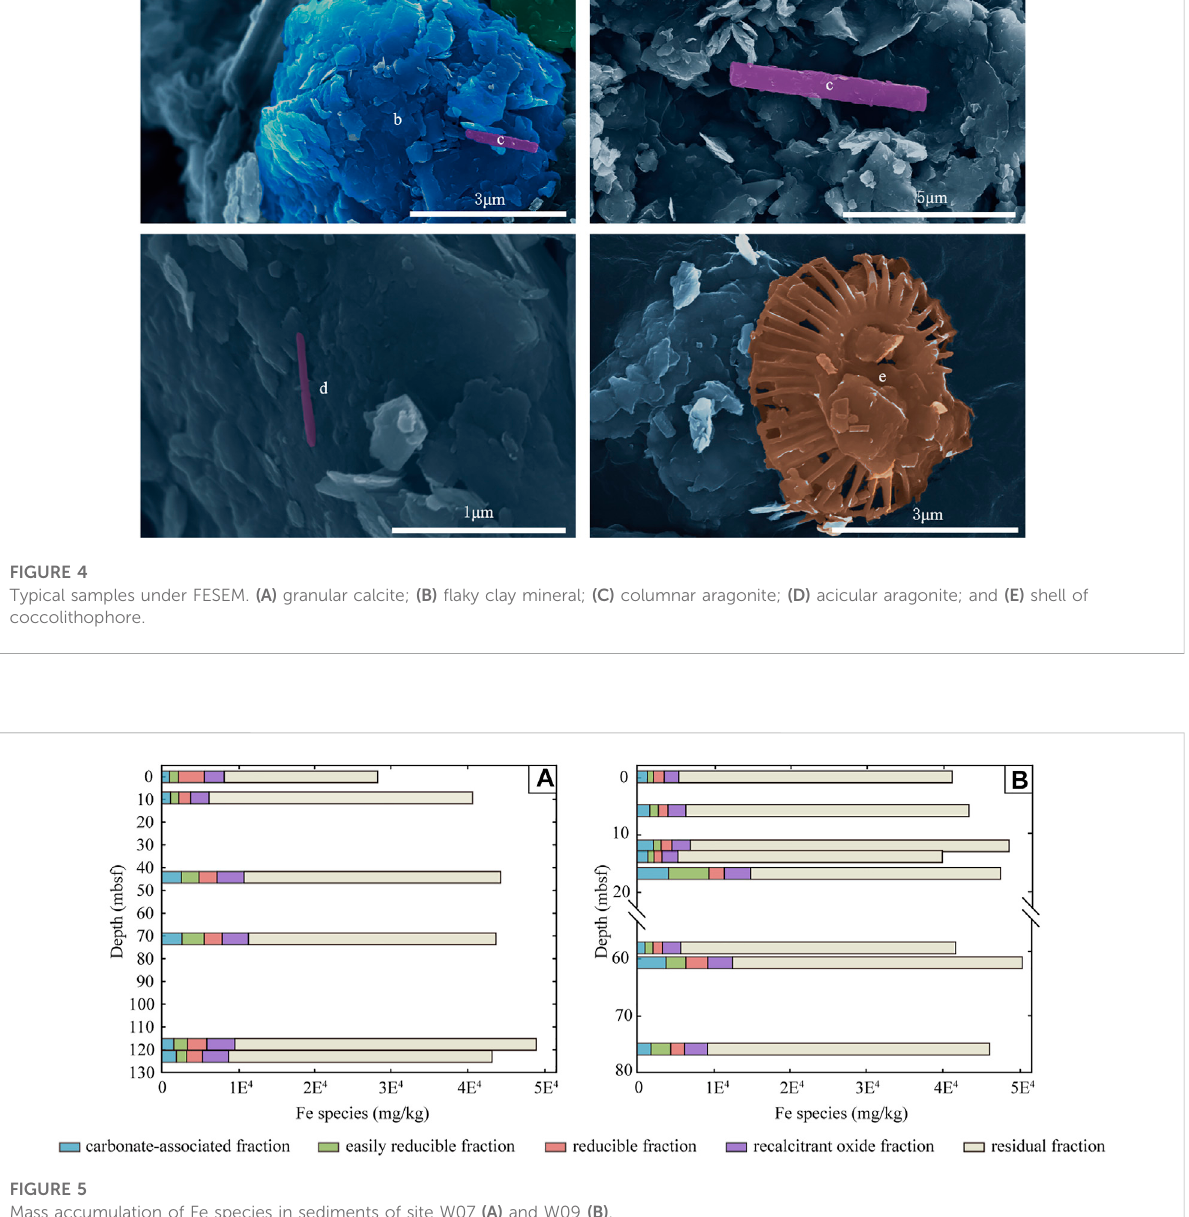
FIGURE 5 Mass accumulation of Fe species in sediments of site W07 (A) and W09 (B)